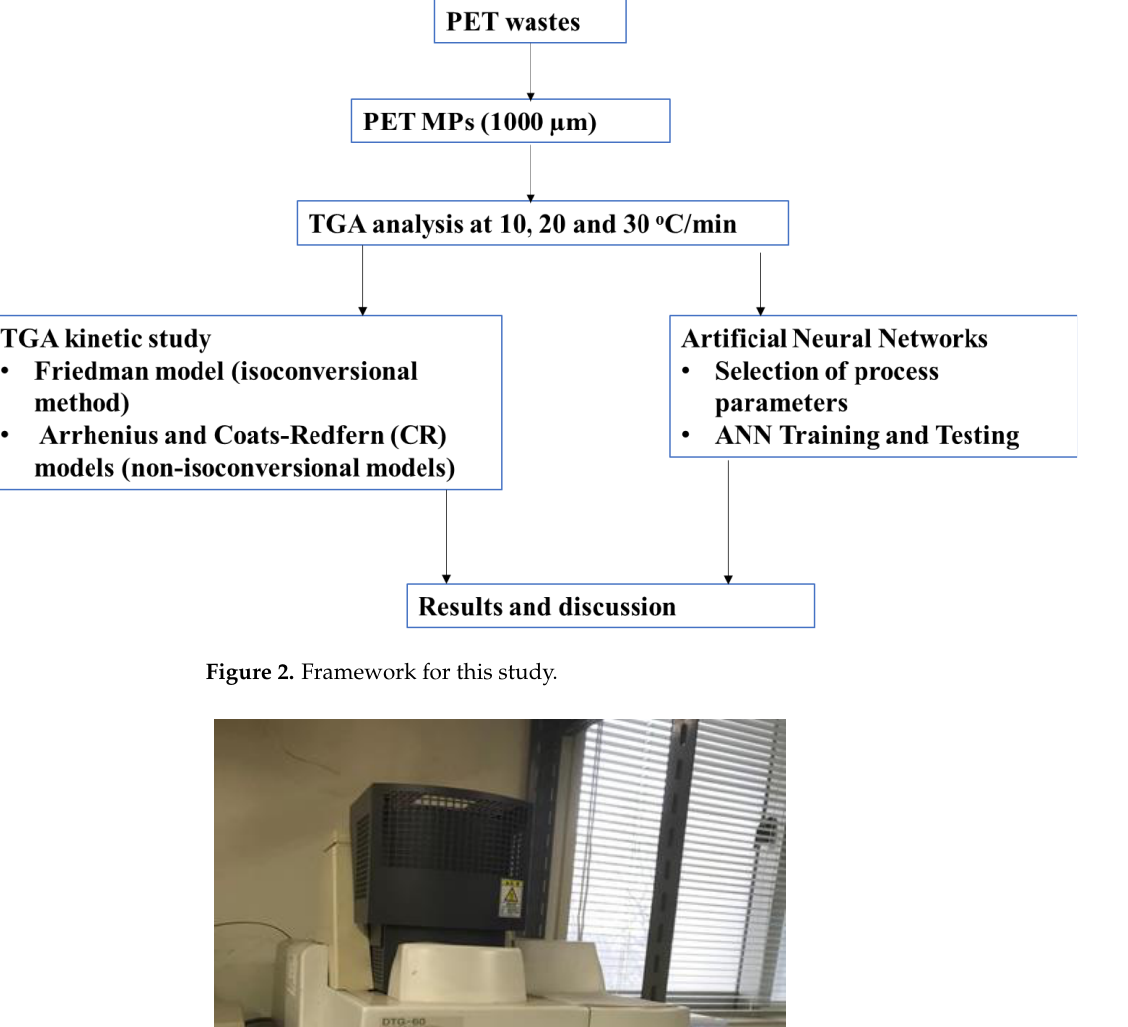
Figure 2. Framework for this study.